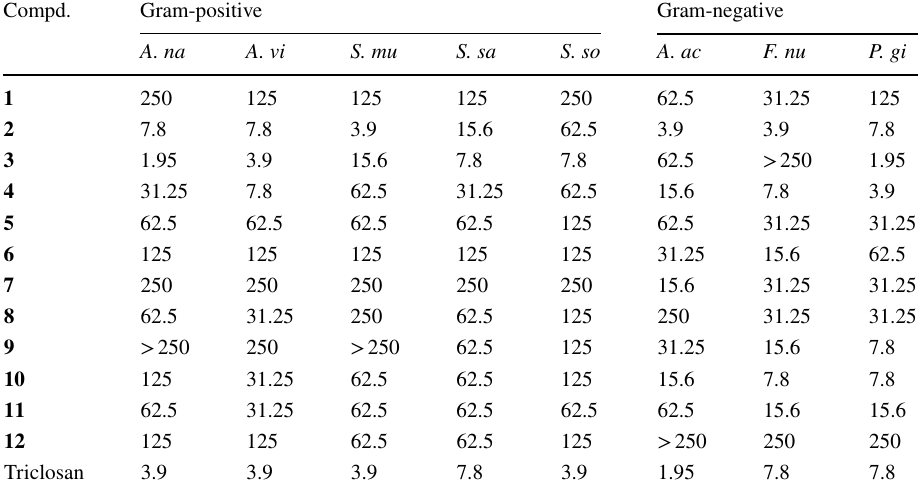
Table 3 Anti-oral microbial activity of compounds 1–12 expressed as MIC